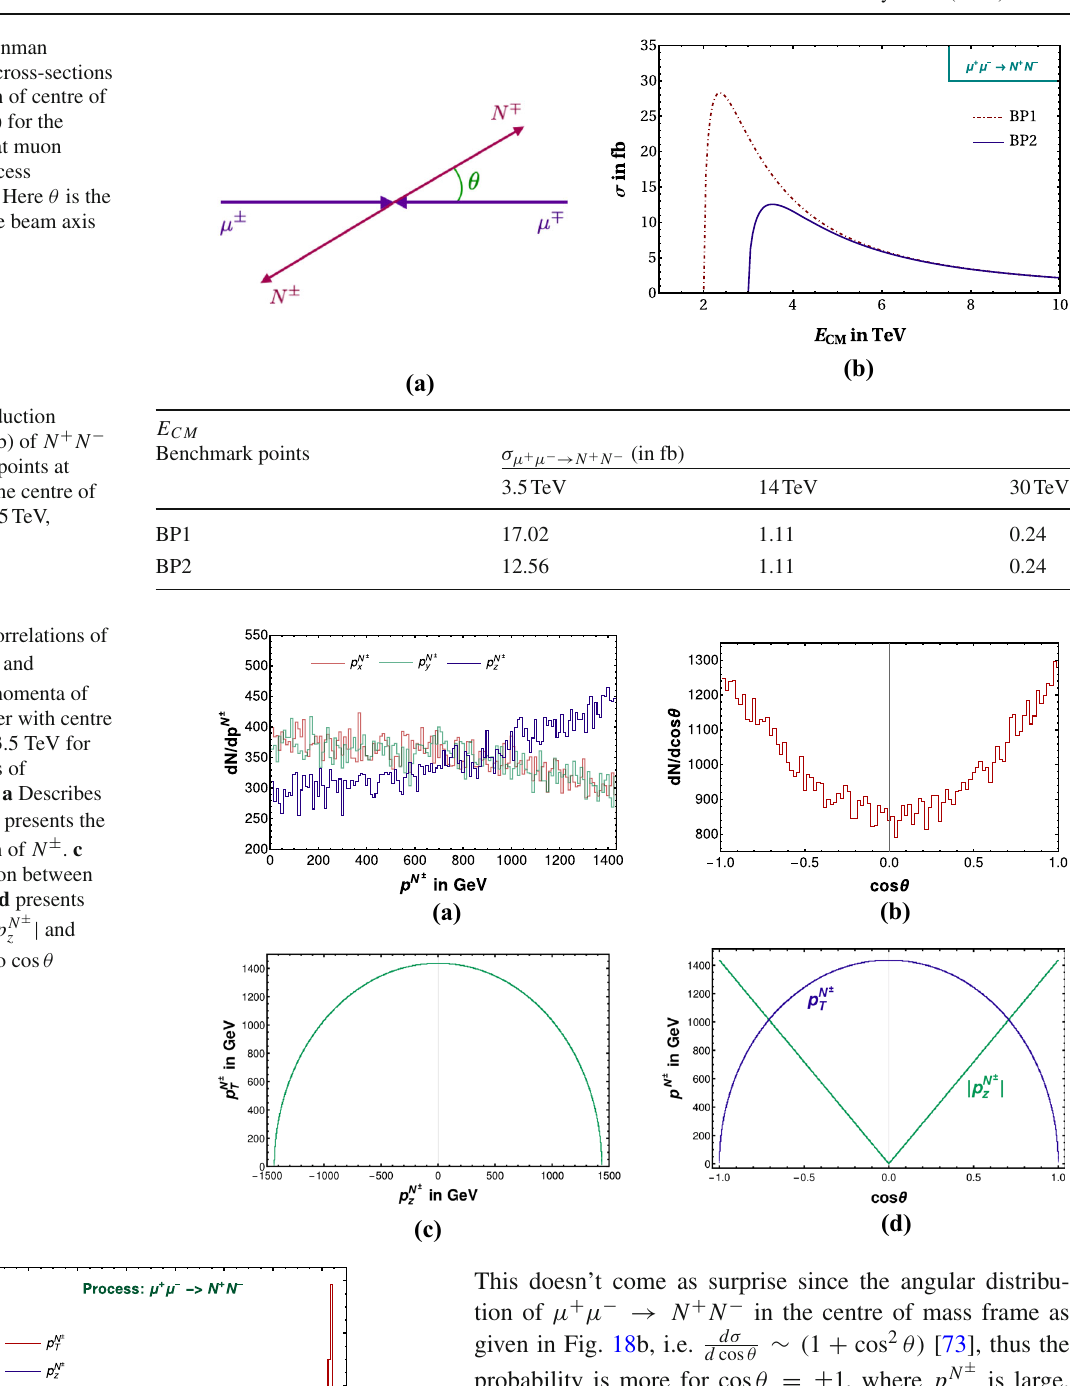
Table 12 The production cross-sections (in fb) of N + N − for the benchmark points at muon collider for the centre of mass energies of 3.5TeV, 14TeV and 30TeV